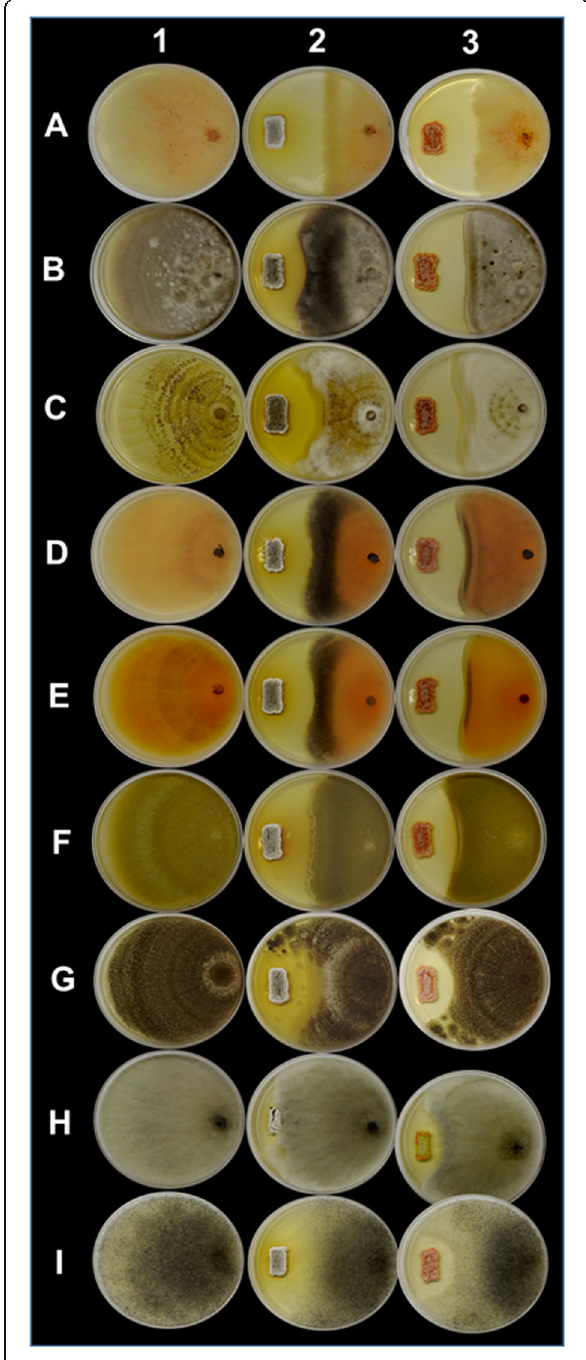
Fig. 3 Antagonist assay by dual confrontation. (A) Colletotrichum musae , (B) Alternaria sp., (C) Colletotrichum sp. M2.1, (D) Colletotrichum sp. M1.2, (E) C . gloeosporioides , (F) Botrytis sp., (G) Aspergillus sp., (H) Rhizoctonia sp., and (I) Rhizopus sp. (1) Control growth, (2) S . lydicus WYEC 108 antagonism, and (3) Streptomyces sp. CACIS-1.5CA